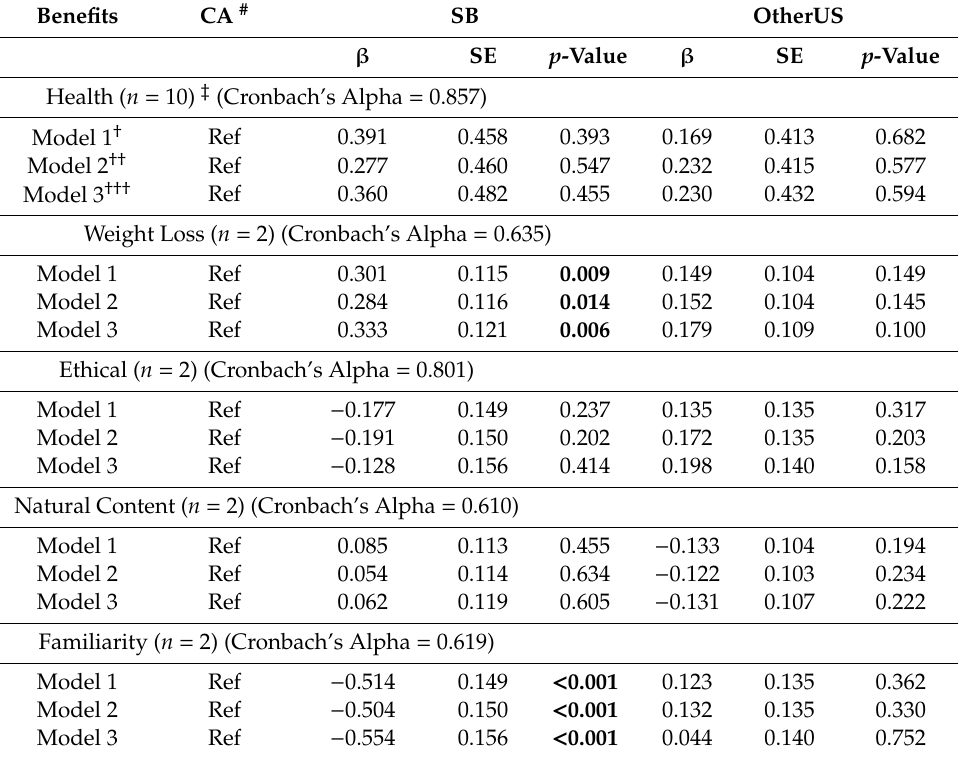
Table 4. Multivariate analysis of MD benefits across geographic